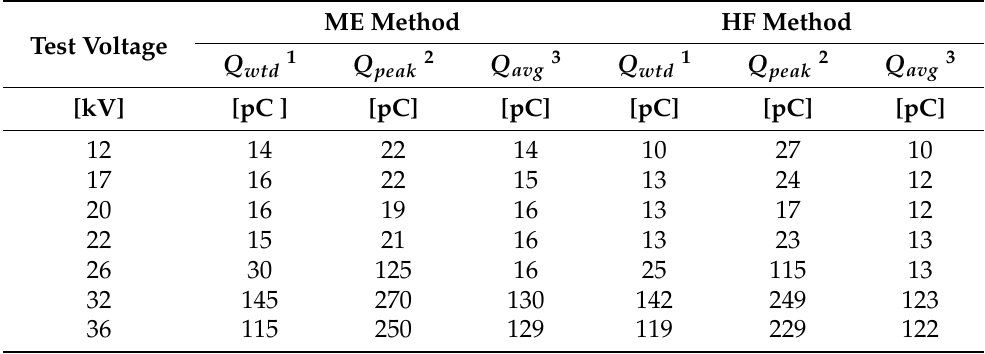
Table 2. Measurement results of Q depending on the U p for the XRUHAKXS 1 × 240/25 cable with the corona rings